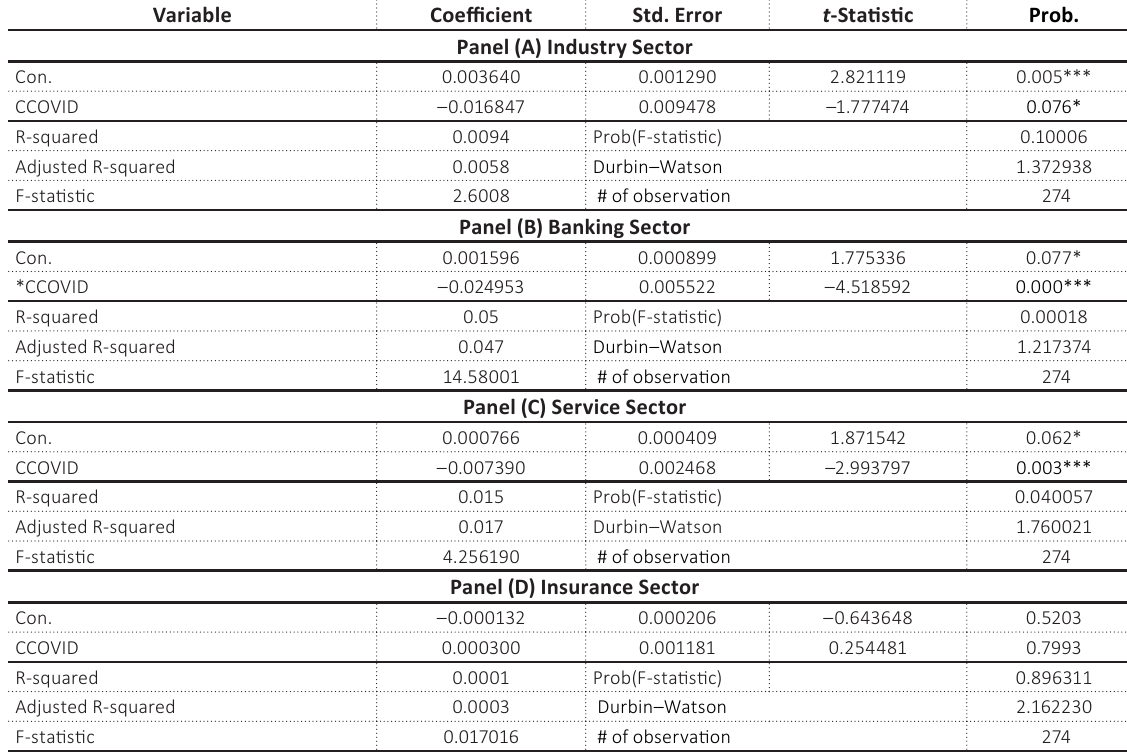
Table 6. Sub-indices’ return and confirmed cases of